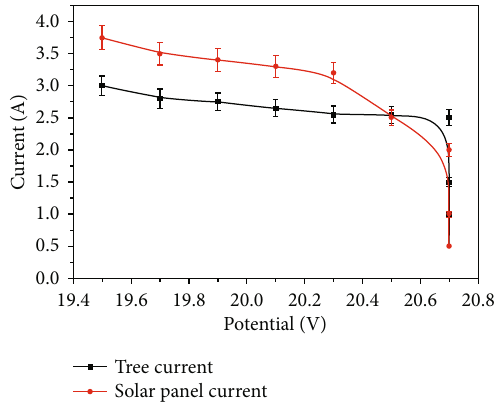
Figure 10: Current according to the voltage.